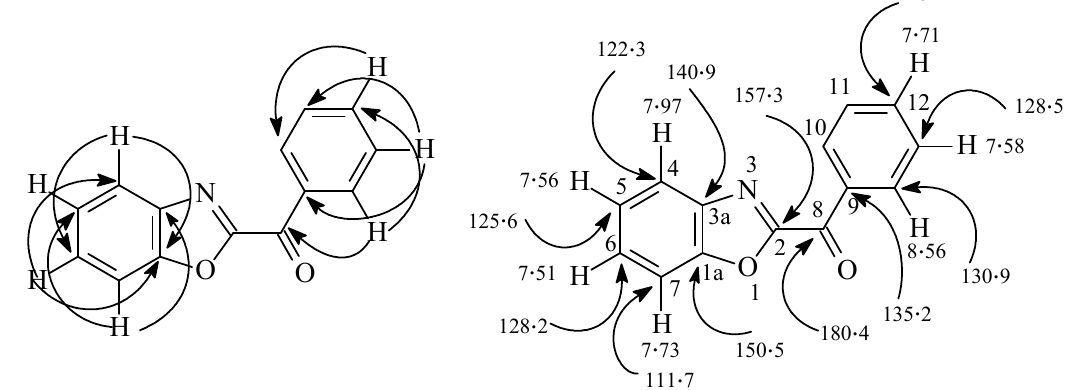
Figure 5. H-C Correlations in the HMBC 2-D experimental of compound 21